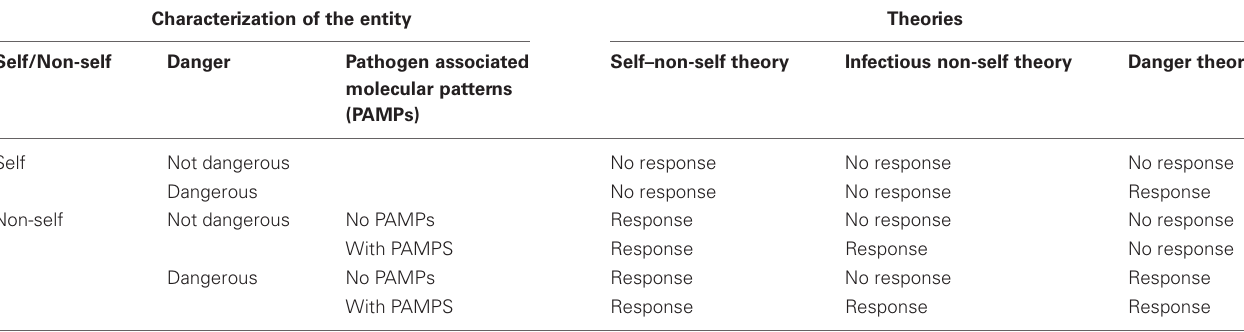
Table 1 | Predictions made by theories of self–non-self, infectious non-self, and danger (after Matzinger, 2002). Characterization of the